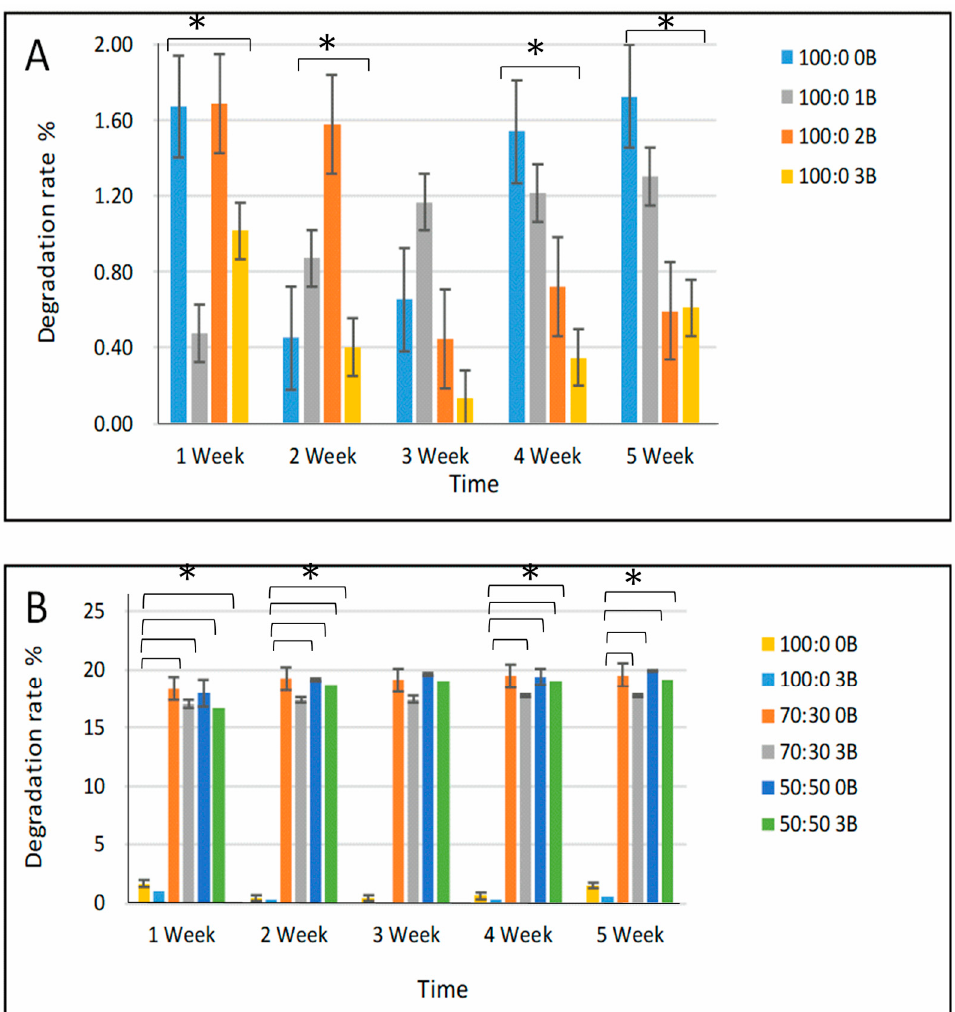
Figure 2. Degradation rate of different cryogel scaffolds up to 5 weeks incubation. ( A ) The cryogels with only high-Mw PVA and variable borax contents. ( B ) The cryogels with mixed Mw PVA and variable borax content. Significance was determined by ANOVA test (* p < 0.05).